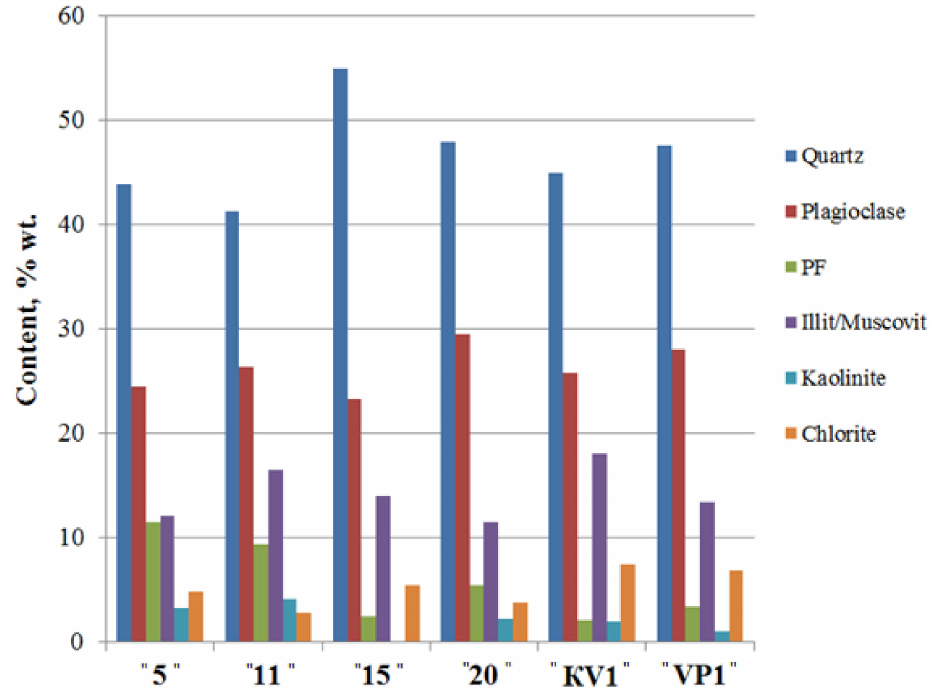
Figure 4. The bulk mineral composition of the sediments of the Cape Muostakh, the Bykovsky Peninsula. PF—potassium